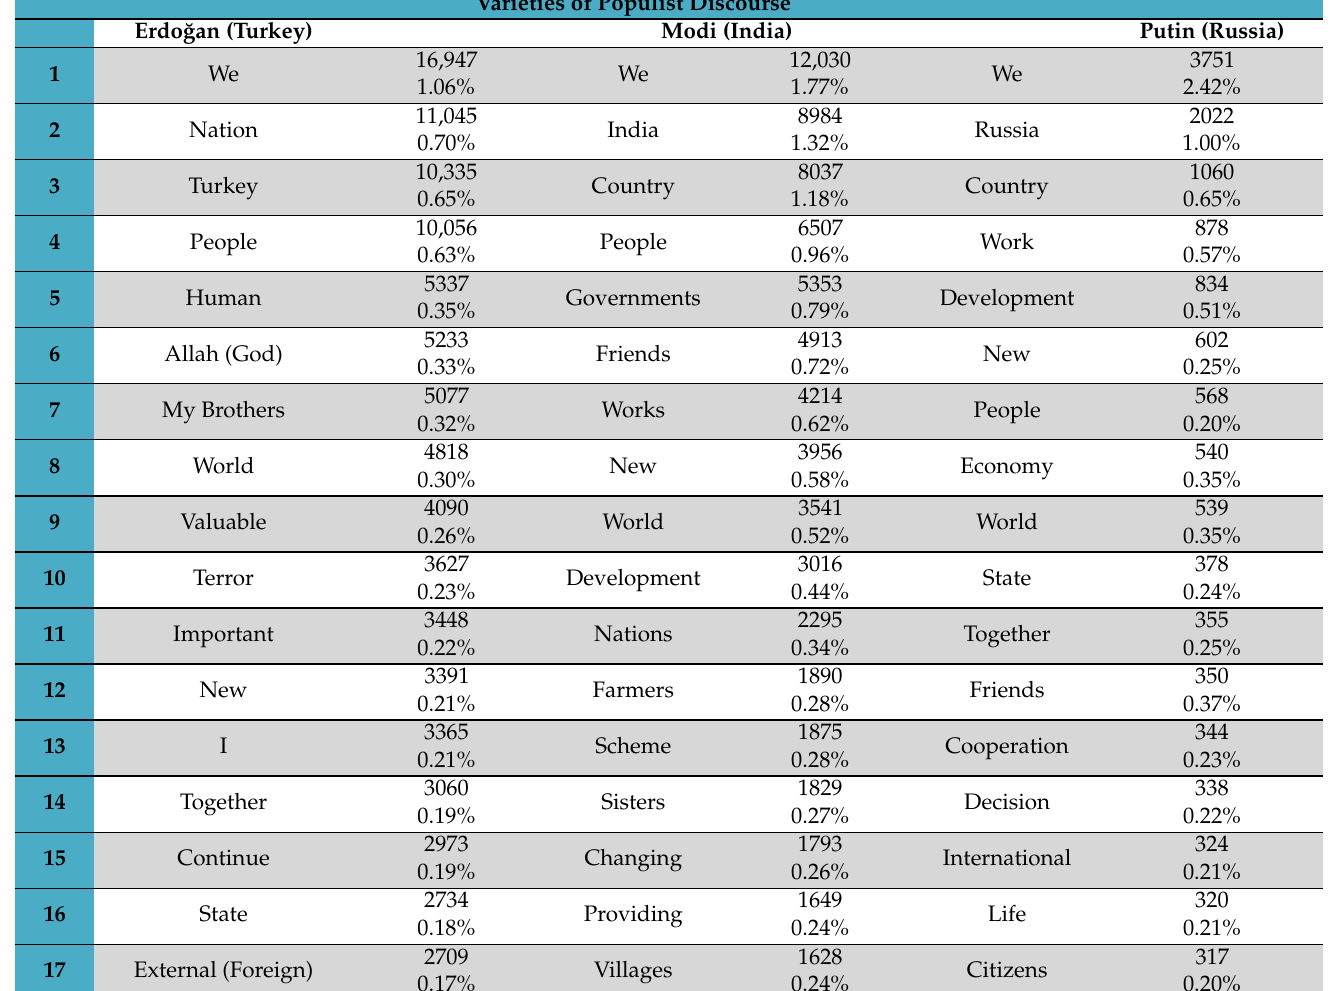
Table 2. Most frequently used words in Erdo˘gan, Modi, and Putin’s